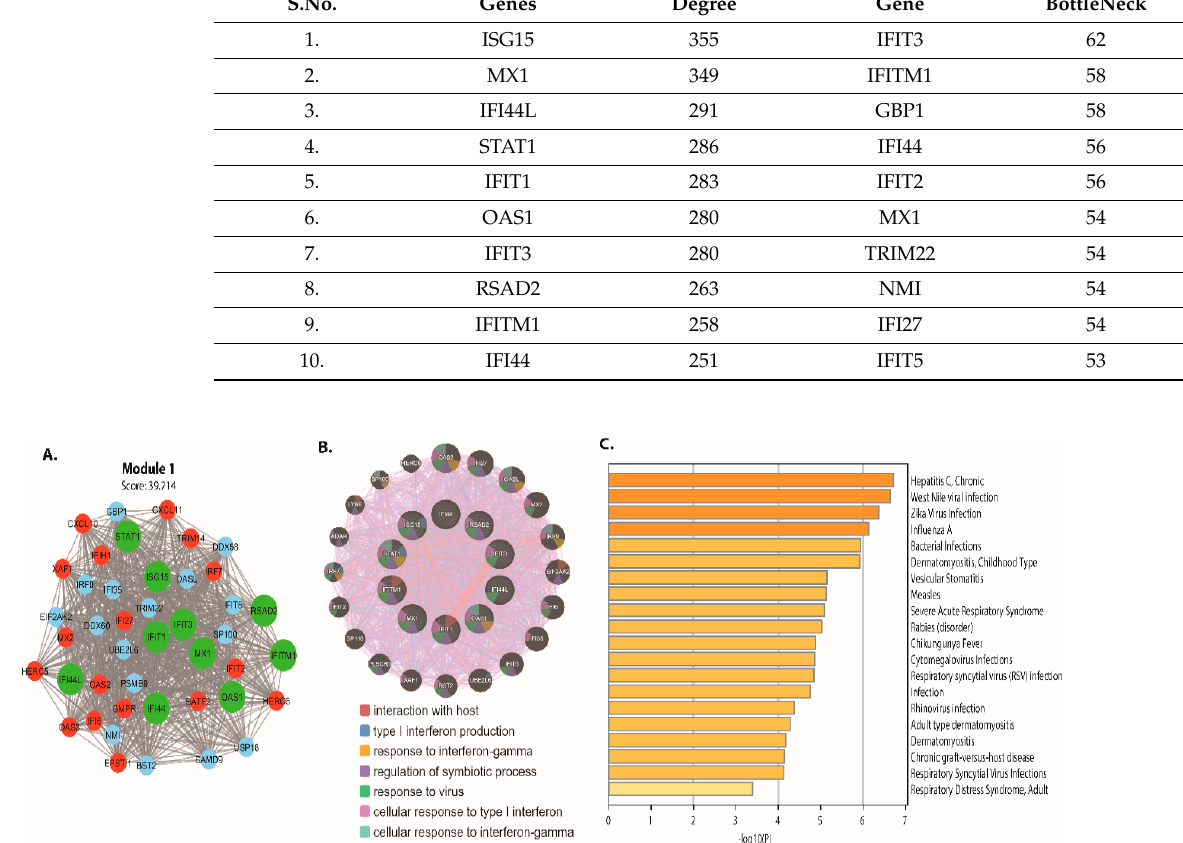
Figure 6. Module 1 PPI network with functional enrichment generated from GeneMANIA. ( A ) A PPI network with 43 nodes and 834 edges yielded the most significant module. ( B ) The module 1 PPI network, which contains 42 genes. Upregulated genes are highlighted in red, downregulated genes are highlighted in cyan, and hub genes are highlighted in green. ( C ) p -values are used to color a bar graph of enriched phrases across module 1 genes. Table 1. Top 10 hub genes expressed in intestinal epithelial tissue of C. parvum infected patient and its topological properties.